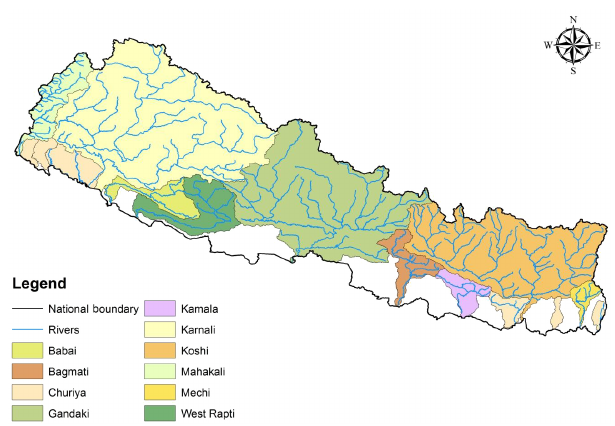
Figure 1. Map of Nepal showing the major river basins.